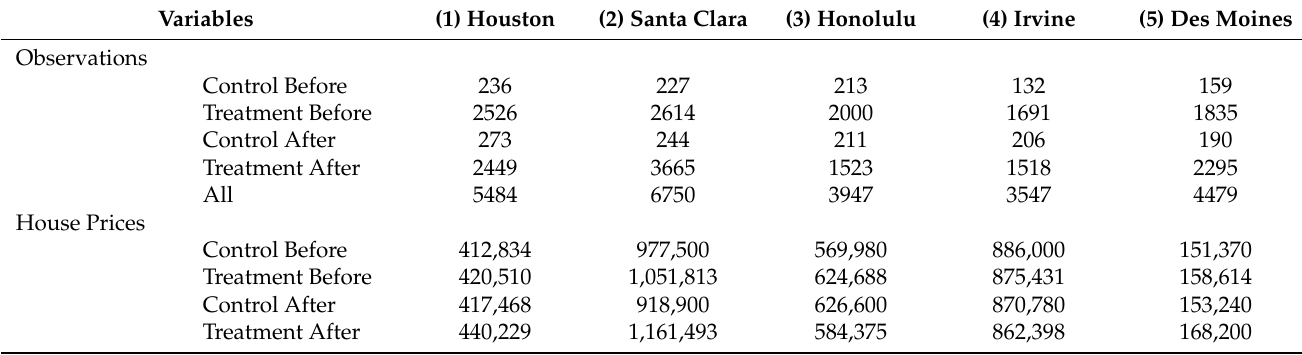
Table 2. Summary Statistics for Housing